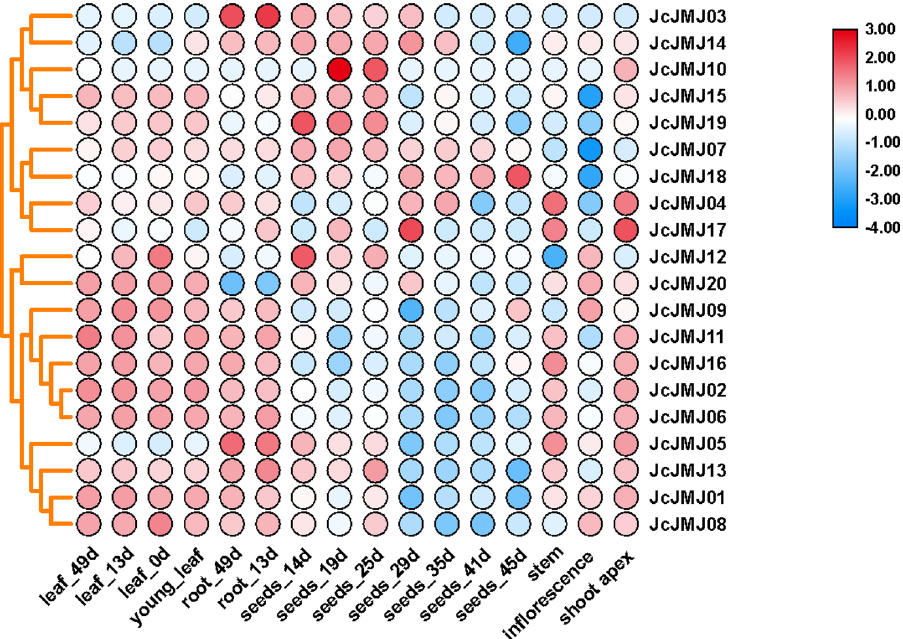
Figure 8. Hierarchical clustering of the expression profiles of 20 JcJMJ genes in 6 tissues. The color scale representing log2 signal values is shown on the right. Blue represents a low level and red indicates a high level of transcript abundance. The different tissues and/or organs are noted on the bottom of each lane. Cluster dendrograms by row scale are shown on the